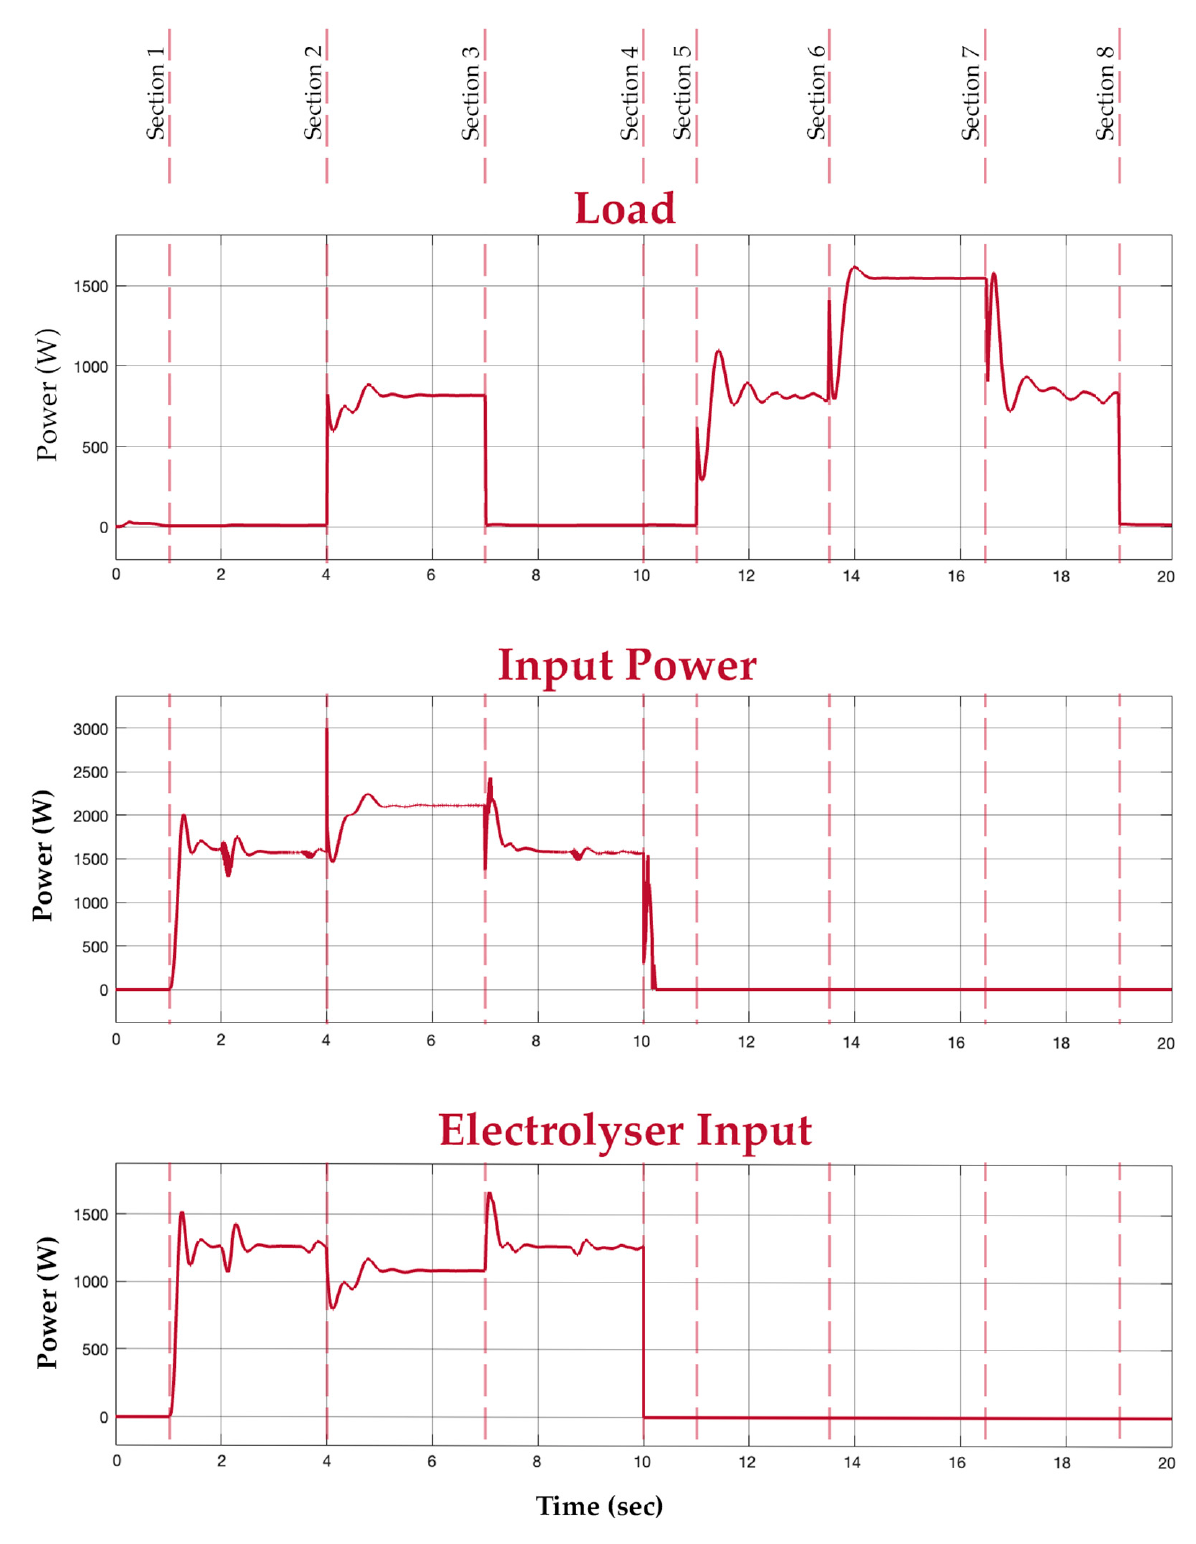
Figure 14. Load, input, and electrolyser graphs.